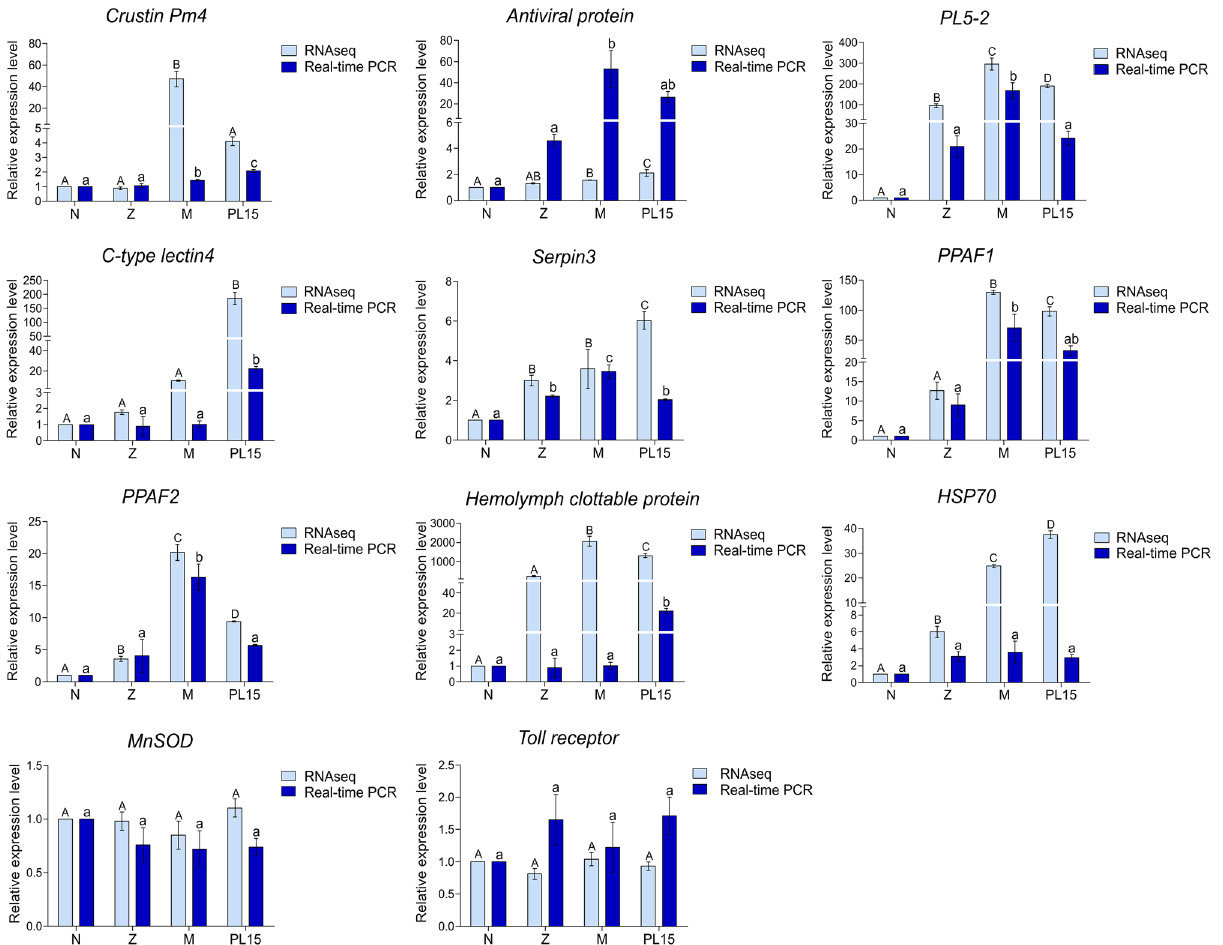
Figure 5. Validation of RNAseq data by quantitative real-time PCR (qPCR) of immune-related transcripts including crustin Pm4 , antiviral protein , penlectin 5–2 ( PL5-2 ), c-type lectin 4 , serpin 3 , prophenoloxidase- activating factor 1 ( PPAF1 ), prophenoloxidase-activating factor 2 ( PPAF2 ), hemolymph clottable protein , heat shock protein 70 ( HSP70 ), superoxide dismutase ( Mn ) ( MnSOD ) and toll-like receptor in nauplius (N), zoea (Z), mysis (M) and 15-day-old postlarva (PL15). The error bars indicate standard error of the mean from biological triplicates. Different letters show significant different by ANOVA ( p value <